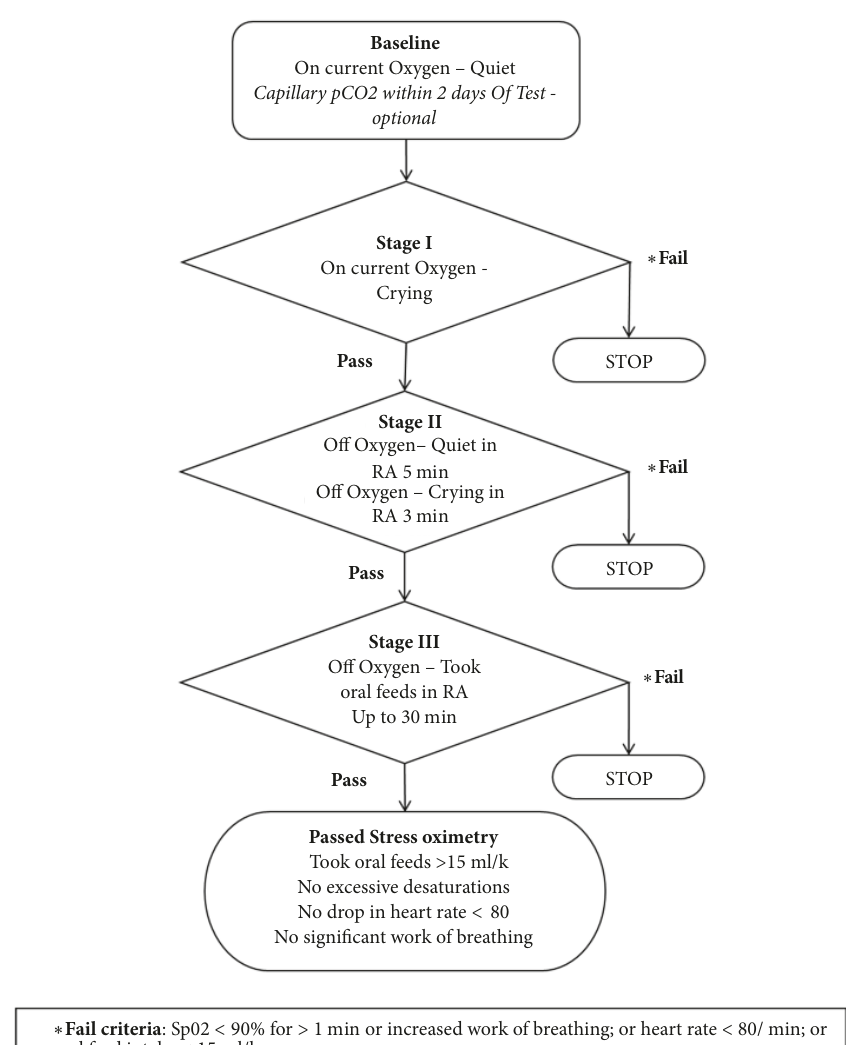
Figure 1: Schema for Stress Oximetry